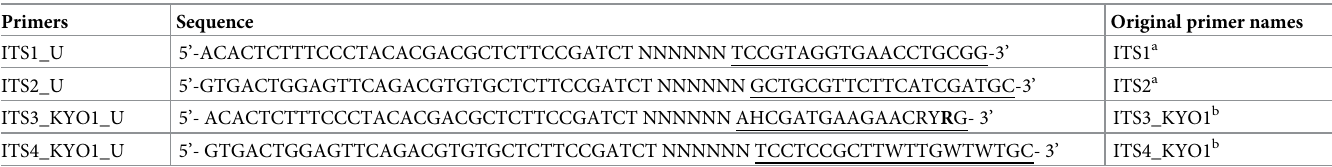
Table 1. Primer sequences for the MiSeq